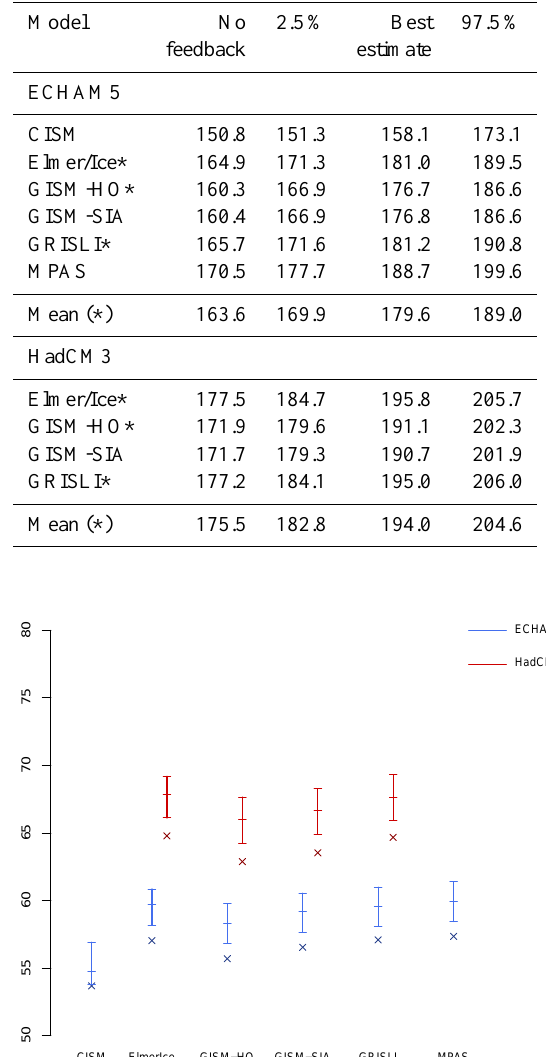
Fig. 1. Projected cumulative GrIS sea level contributions for the ECHAM5 and HadCM3 A 1B projections at 2100. Crosses mark simulations with no elevation feedback. Bars mark the estimated 95% credibility intervals and (central tick) best estimates of the el- evation feedback parameterisation.